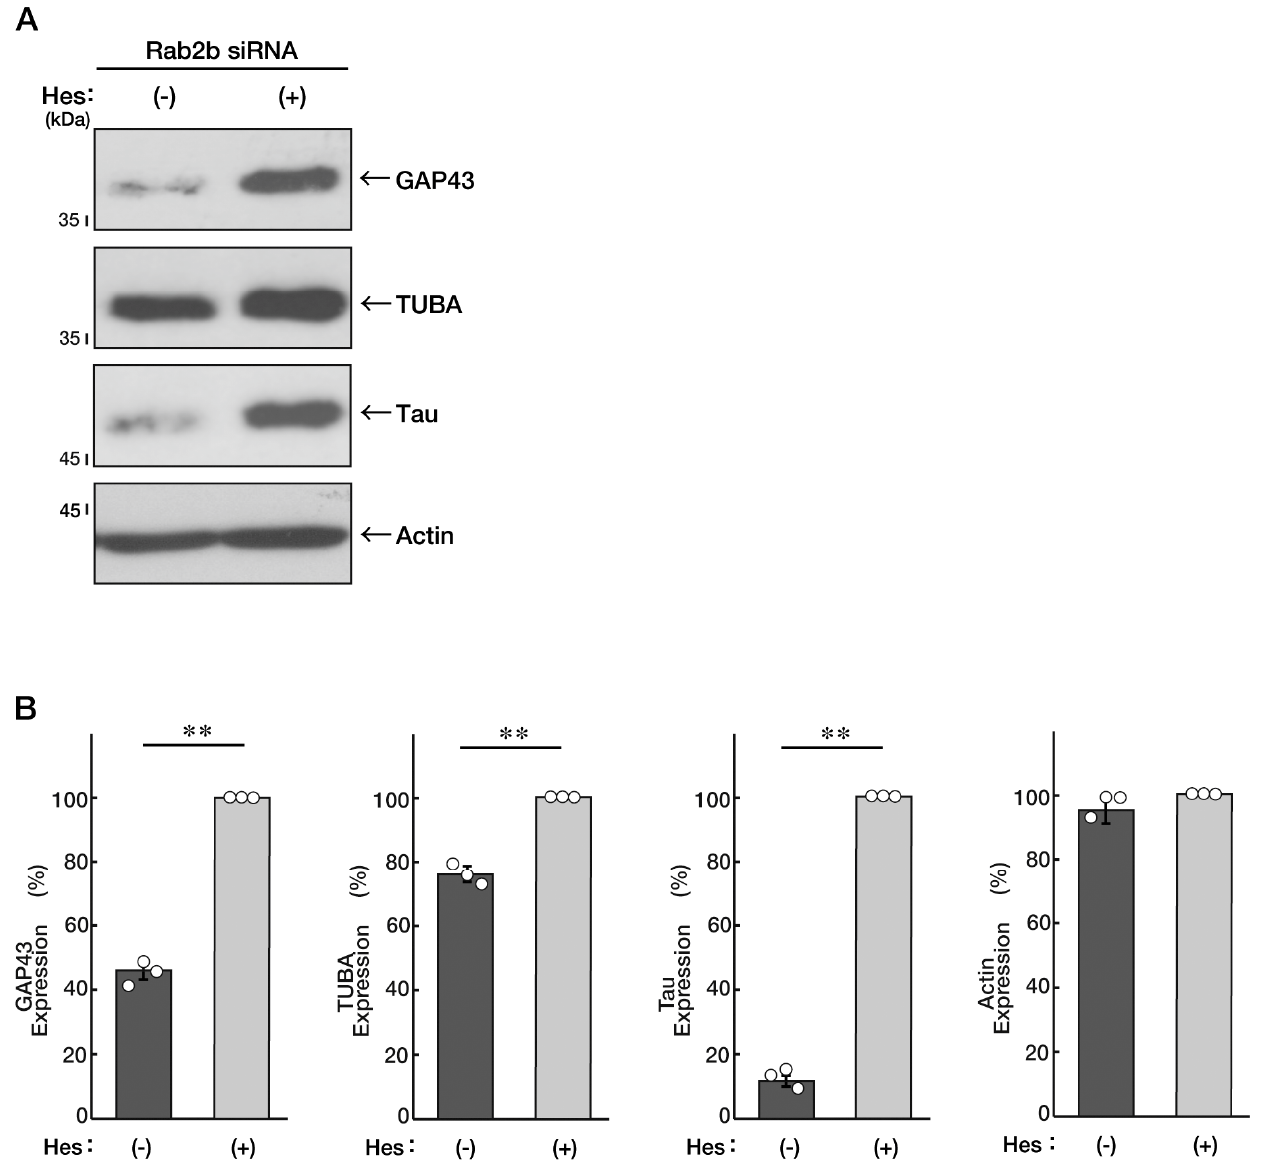
Figure 6. Hesperetin recovers decreased marker protein levels induced by Rab2b knockdown. ( A , B ) N1E-115 cells were transfected with Rab2b siRNAs and treated with a control vehicle (minus hesperetin [minus Hes]) or hesperetin (plus Hes, 1 μ M) for 3 days. Each cell lysate was collected for an immunoblotting for an antibody against GAP43, TUBA, Tau, or actin. Immunoreactive bands were quantitatively calculated compared to the respective controls (100%) and statistically depicted as graphs (** p < 0.01; n = 3 blots). White circles show percentages in the respective independent experiments.